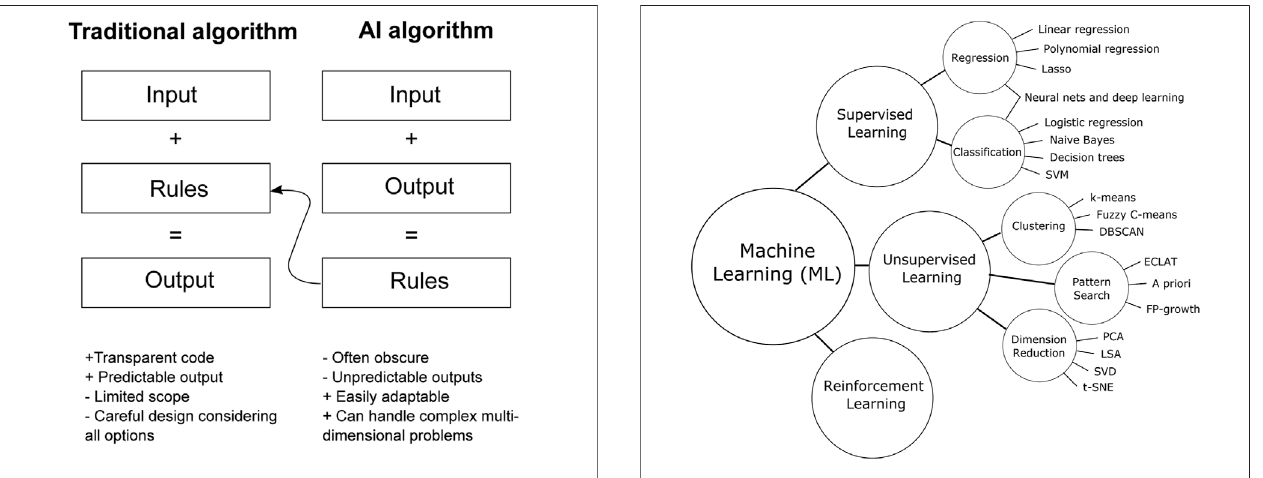
FIGURE 3 | Categories of ML